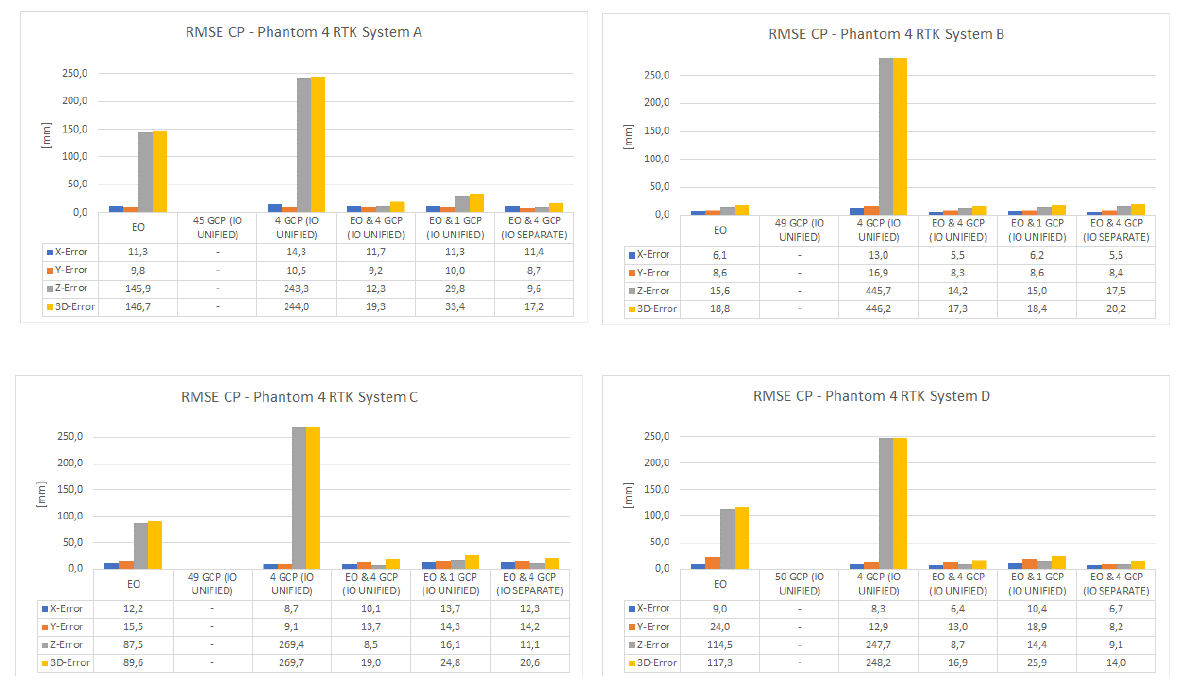
Figure 5. RMSE values at the check points (CP) as a function of the orientation type (direct: EO – indirect: GCP – integrated: EO+GCP) (systems A -